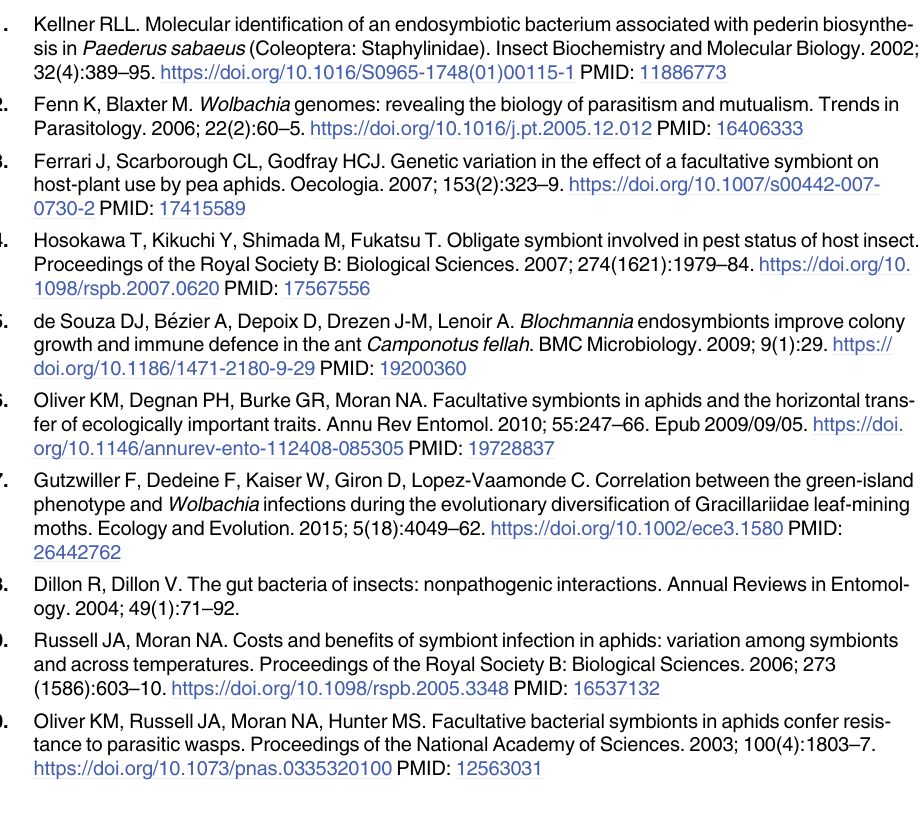
S2 Table. Diversity analysis of microbial community associated larvae of C . capitata feed- ing on different host